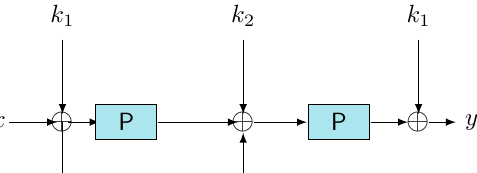
Figure 3.1: pEDM Construction with k 1 and k 2 indepedent keys and P is an n -bit